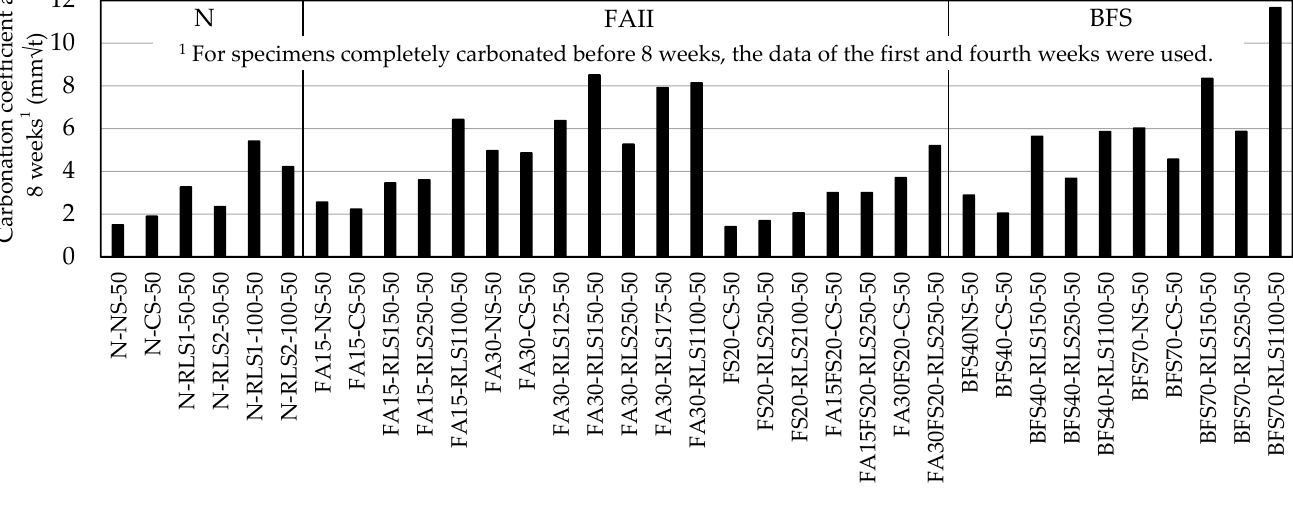
Figure 4. Carbonation coefficient of mortar.